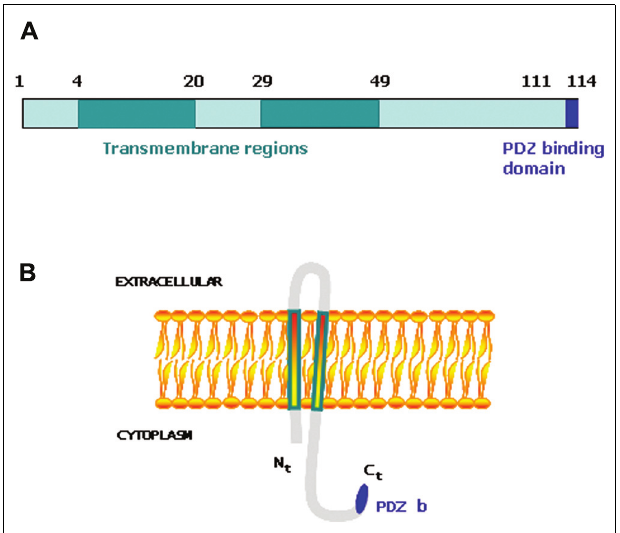
FIGURE 1 | (A) Schematic representation of MAP17 protein domains. (B) Schematic representation of MAP17 disposition in the membrane.